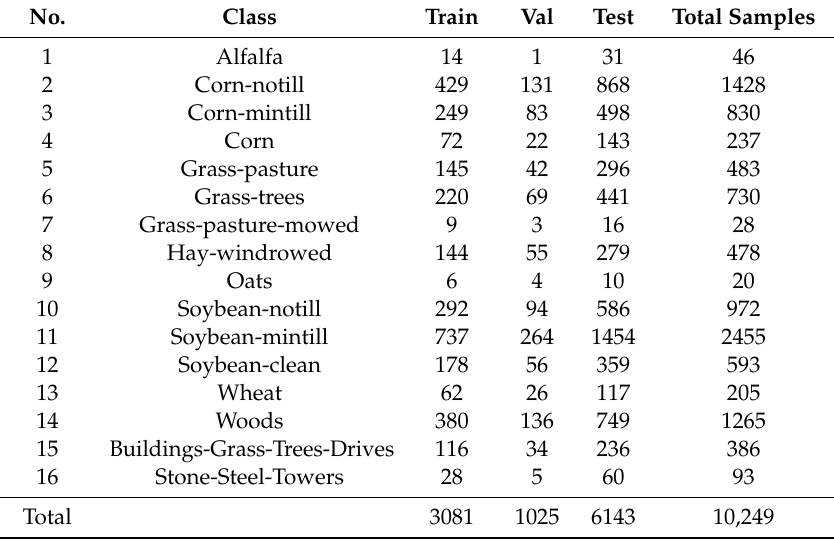
Table 4. The number of training, validation, test, and total samples in the IN dataset.